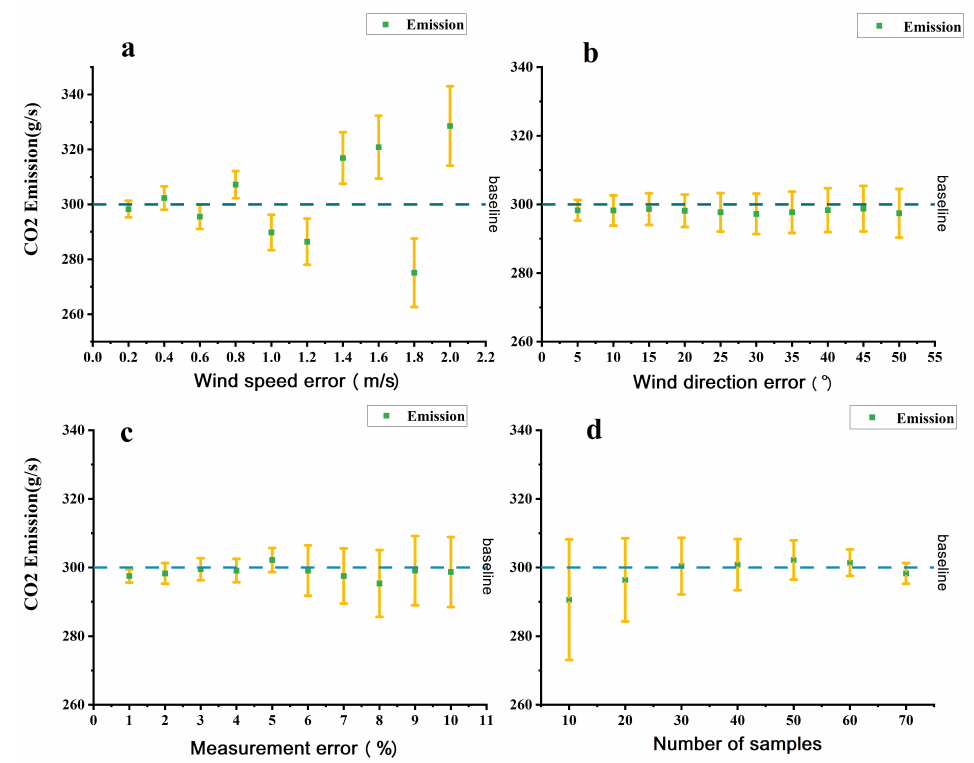
Figure 3. Effect of four types of errors on retrieval results. The base set is the same as Table 1 and the baseline is the actual CO 2 emission; ( a ) add additional errors to wind speed from 0.2 m/s to 2.0 m/s with internal of 0.2 m/s; ( b ) add errors for wind direction, increase the range from 5 degrees to 50 degrees with an interval of 5 degrees; ( c ) adding random error for the measurement, from 1% measurement error increase to 10% error with an interval of 1%; ( d ) changing the number of samples from 10 to 70 with an interval of